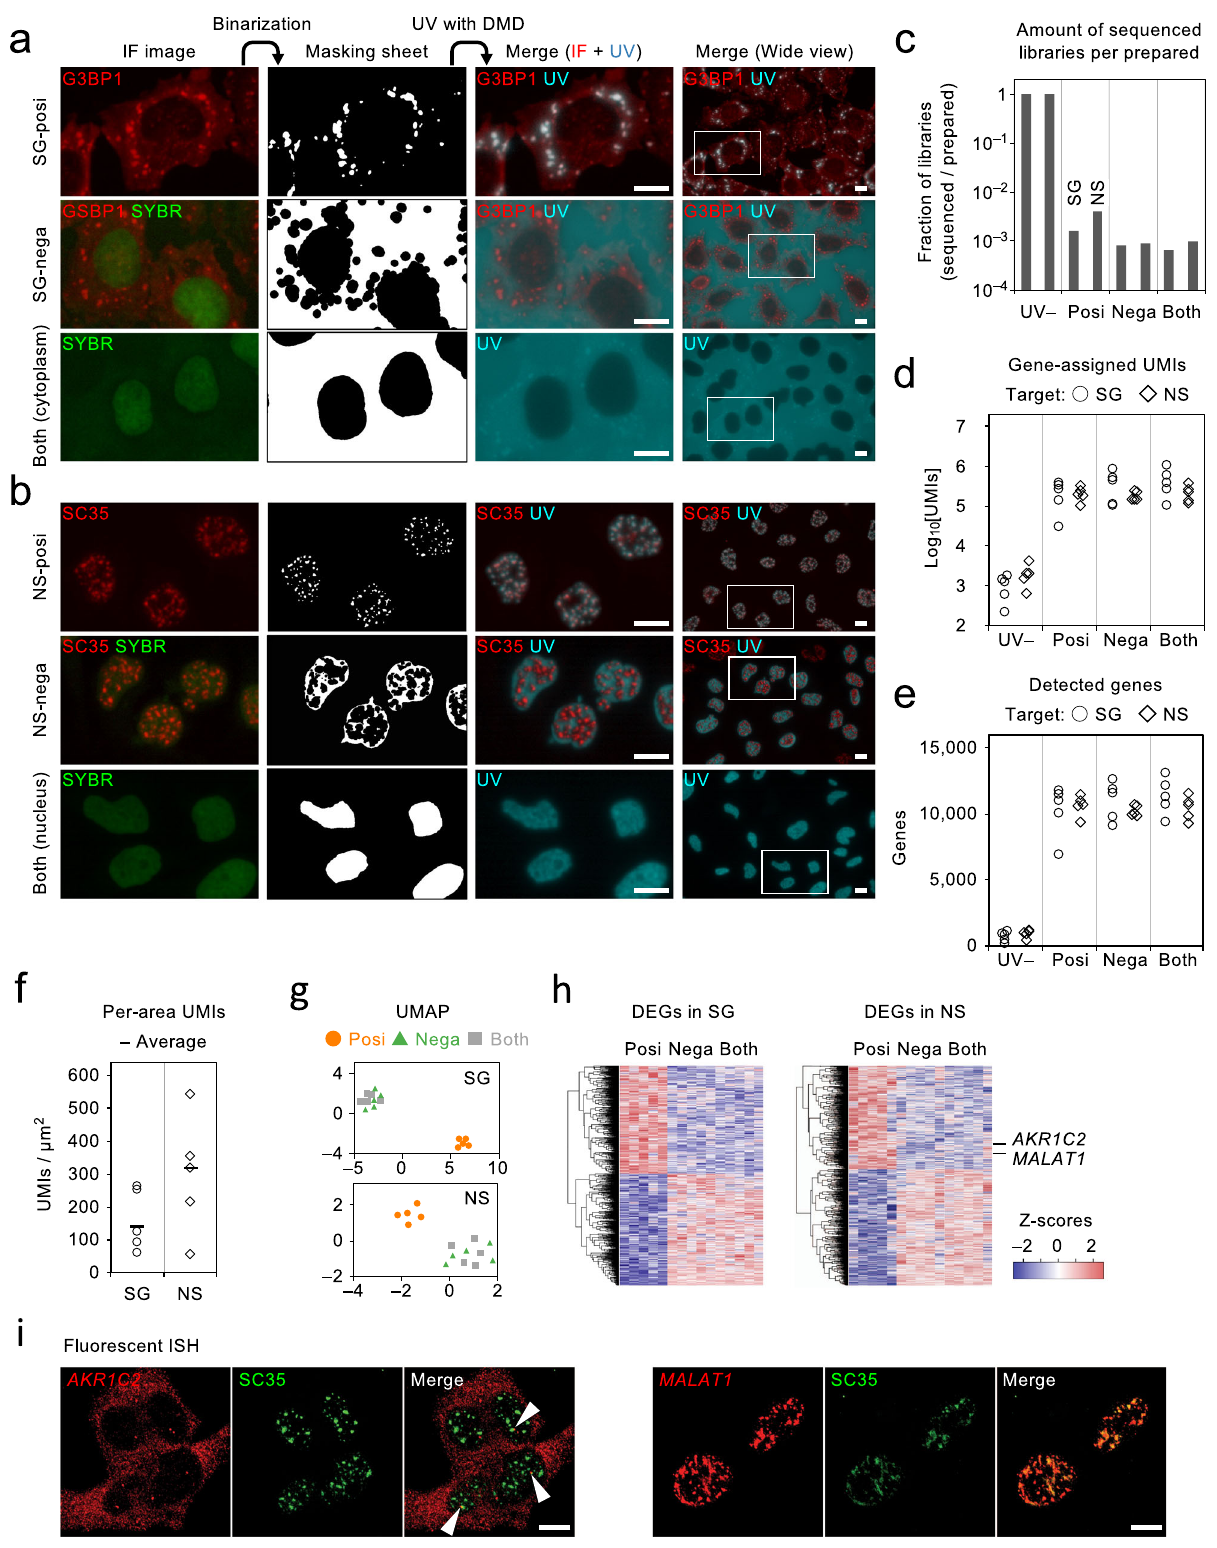
Fig. 5 PIC RNA-seq for subcellular and subnuclear microstructures. a , b Images of green nuclei, red immuno fl uorescence (IF) for SGs ( a ) and NSs ( b ), resulting in masking sheets, and merged images of IF and DMD-assisted UV irradiation are shown. A representative image was shown out of fi ve replicates. c The amounts of the sequenced libraries relative to UV – samples (set as 1) are shown. d – f The numbers of gene-assigned UMIs ( d ), detected genes ( e ), and per-area UMIs ( f ) are shown, with the horizontal lines indicating the average of replicates ( f ). g Two-dimensional reduction by UMAP analysis for the expression pro fi les. h DEGs are clustered and shown in heat maps. i Fluorescent ISH for AKR1C2 and MALAT1 transcripts. A representative image was shown out of three replicates. Scale bars, 10 μ m. Source Data is available as a Source Data fi